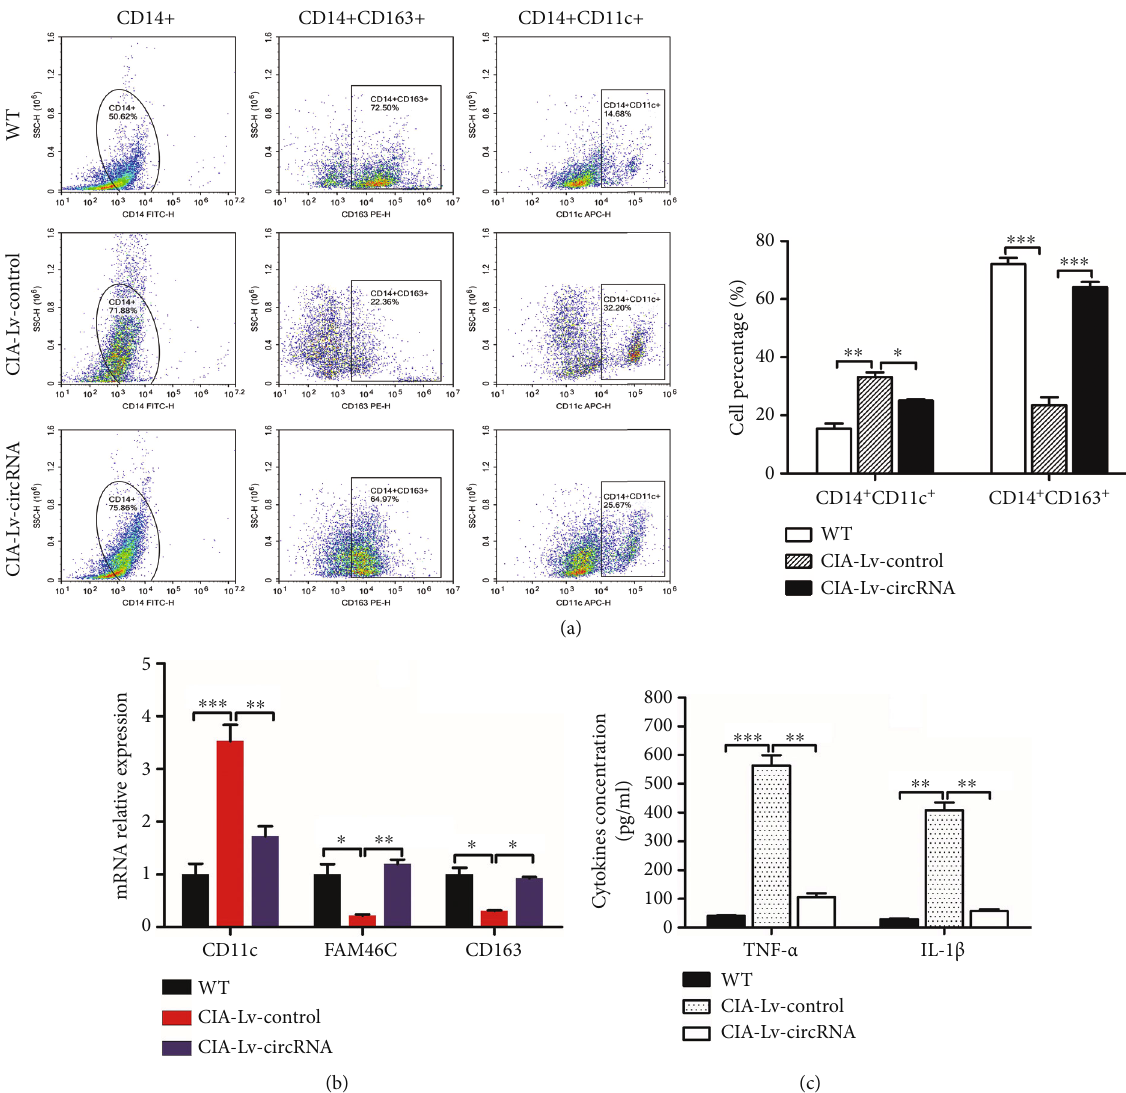
Figure 9: circRNA_17725 promoted M2 polarization in CIA mice. (a) Flow cytometry: CD14 + CD163 + cells and CD14 + CD11c + cells in fi ltration in spleens from CIA mice ( ∗ P < 0 : 05 , ∗∗ P < 0 : 01 , and ∗∗∗ P < 0 : 001 ; 6 mice/group, n = 3 ). (b) Real-time PCR: CD11c, CD163, and FAM46C mRNA expressions in spleen mononuclear cells of CIA mice ( ∗ P < 0 : 05 , ∗∗ P < 0 : 01 , and ∗∗∗ P < 0 : 001 ; 6 mice/group, n = 3 ). (c) ELISA: decreased TNF- α and IL-1 β in the plasm from Lv-circRNA-transfected macrophage-treated CIA mice ( ∗∗ P < 0 : 01 , ∗∗∗ P < 0 : 001 ; 6 mice/group, n = 3